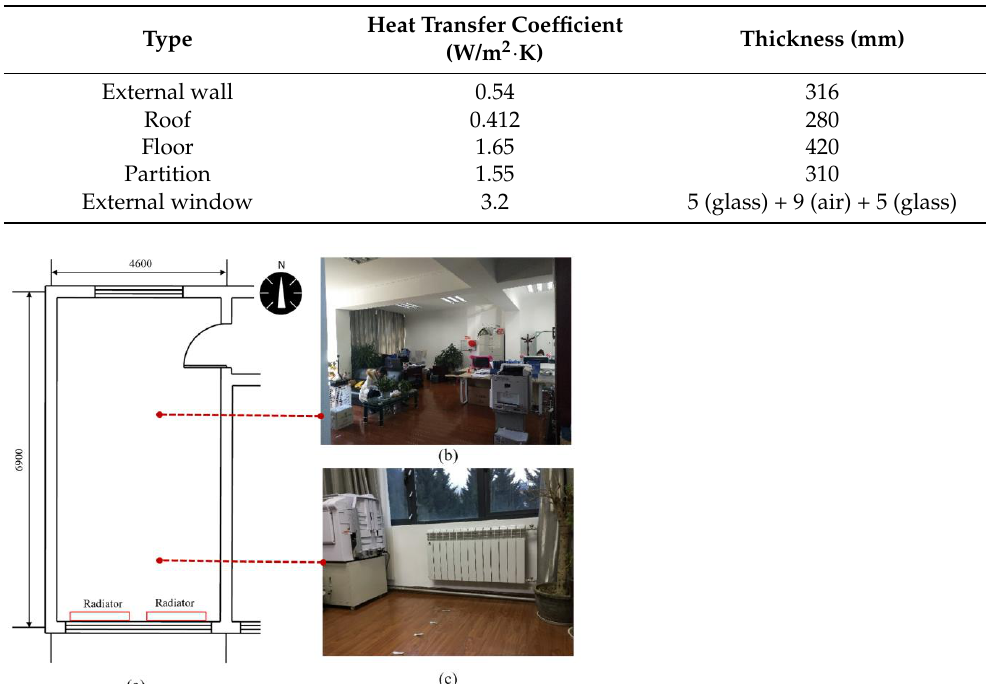
Table 2. Thermal properties of the building structure.